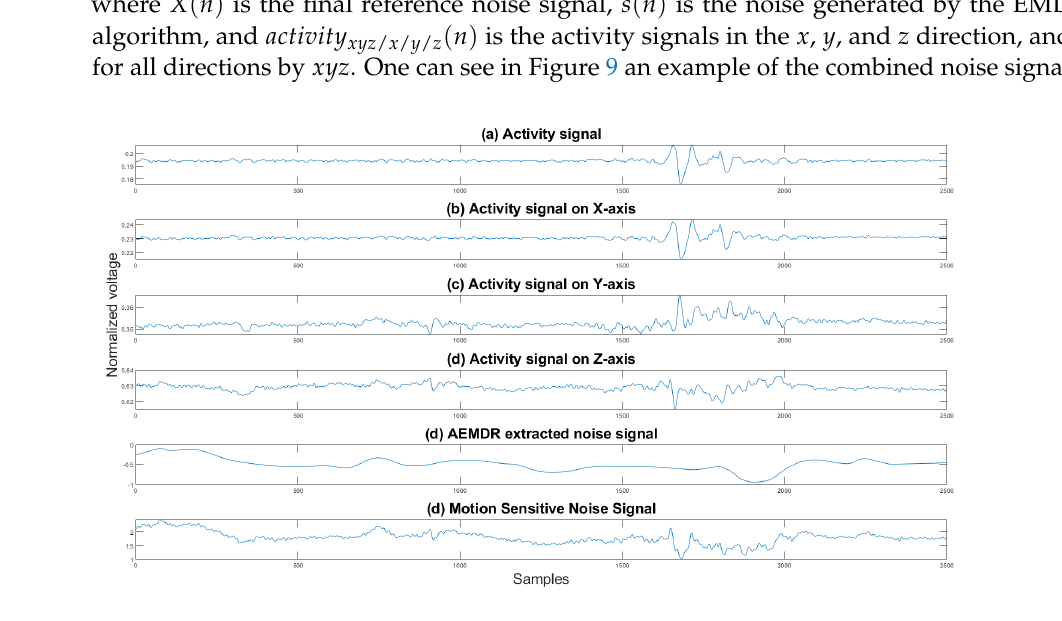
Figure 9. Activity signals, EMD noise signal, and the motion-sensitive reference signal. The y axis is the normalized voltage, and the x axis is the sample